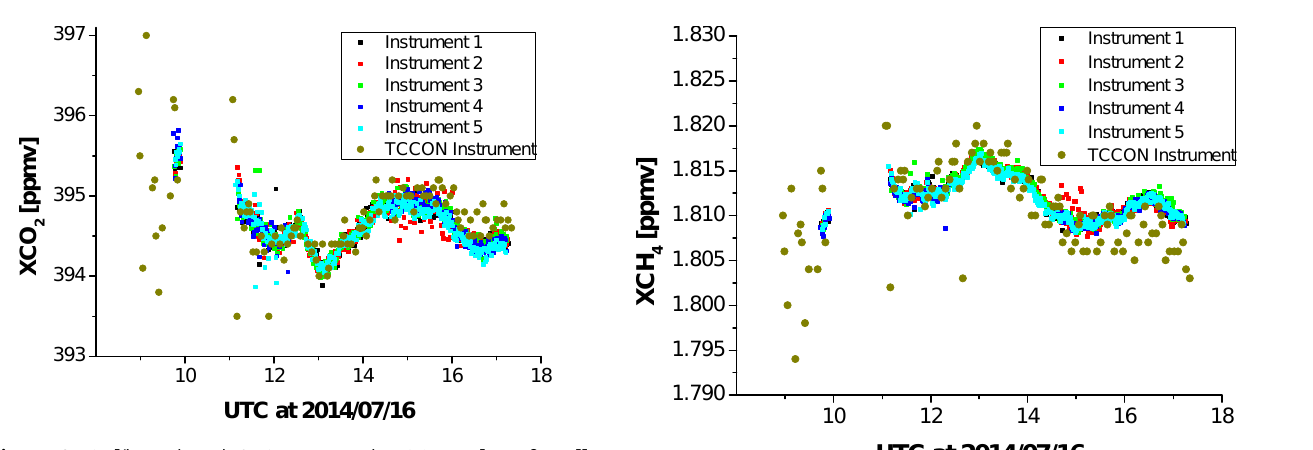
Figure 9. Calibrated and SZA corrected XCO 2 values for all EM27/SUN spectrometers on 16 July 2014. Golden dots show XCO 2 data from a co-located TCCON instrument. Figure 10. Calibrated and SZA corrected XCH 4 values for all EM27/SUN spectrometers on 16 July 2014. Golden dots show XCH 4 data from a co-located TCCON